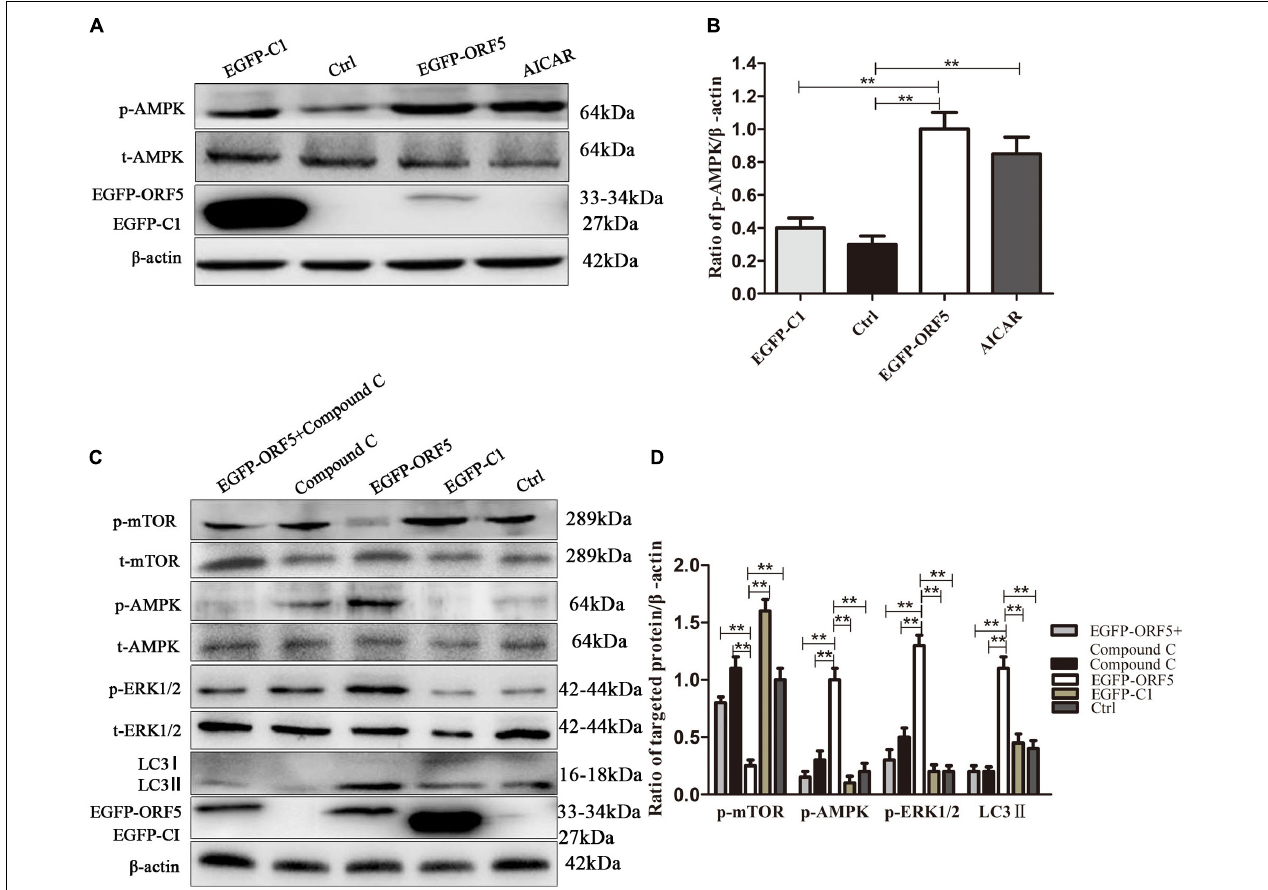
FIGURE 5 | ORF5 protein upregulates phosphorylation of AMPK. (A) PK-15 cells were transfected with EGFP-ORF5 or EGFP-C1 for 48 h. AICAR was used as a positive control. p-AMPK and t-AMPK were detected by immunoblotting. (B) Perform a T -test on the grayscale analysis of the (A), the ratio of targeted protein to β -actin. (C) PK-15 cells were pretreated with Compound C for 2 h and then transfected with EGFP-C1, EGFP-ORF5. After 48 h, immunoblot was used to detect p-mTOR, t-mTOR, p-AMPK, t-AMPK, p-ERK1/2, t-ERK1/2, LC3II were detected by immunoblotting 48 h post-transfection. (D) T -test on the grayscale analysis of the (C) , the ratio of targeted protein to β -actin. * p < 0.05, ** p <